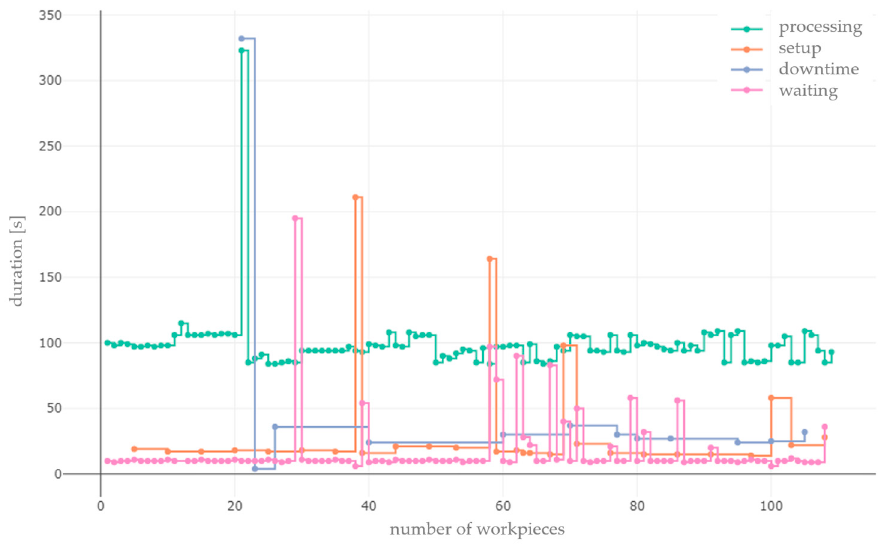
Figure 8. Time series graphs of the defined states of a workstation in a test run. The x -axis shows the number of workpieces, whereby the processing state serves as